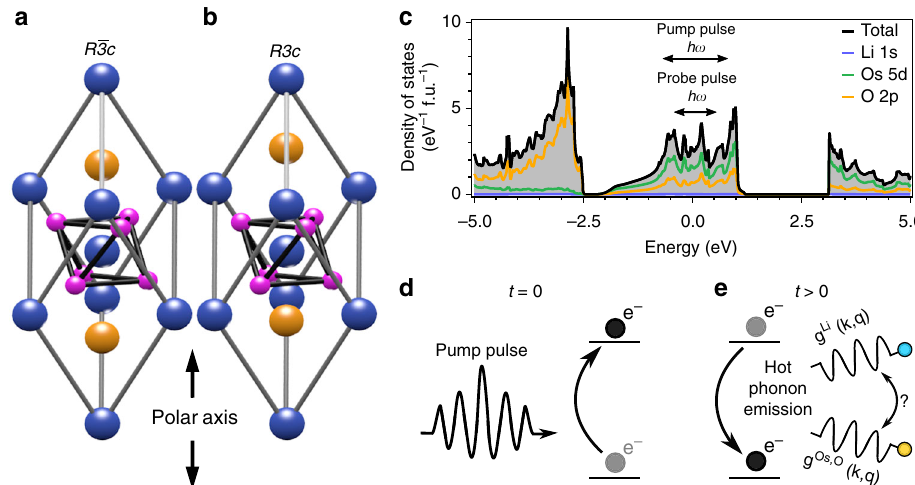
Fig. 1 Scheme for probing electron – phonon interactions of LiOsO 3 Crystal structure of LiOsO 3 in a nonpolar R (cid:1) 3 c and b polar R 3 c phases with blue, orange, and pink spheres representing Os, Li, and O atoms, respectively. These phases are distinguished by the displacement of the Li ions along the polar axis (black arrows). c Density functional theory calculation of the orbital resolved electronic density of states of the R 3 c structure of LiOsO 3 (see Supplementary Note 1). Our pump (1.56 eV) and probe (0.92 eV) pulse energies permit excitation and monitoring of only intra-band photo-excitations, as shown by the black arrows in the inset. d , e A cartoon of our experimental scheme for probing itinerant electron – polar phonon interactions in LiOsO 3 . d An intense pump pulse generates electronic excitations within the metallic band of LiOsO 3 at an initial time t = 0. e These excitations relax at later times t > 0 by coupling to the lattice, naturally embedding the strength of the electron – phonon coupling g ( k , q ) in their relaxation rate. By comparing the temperature